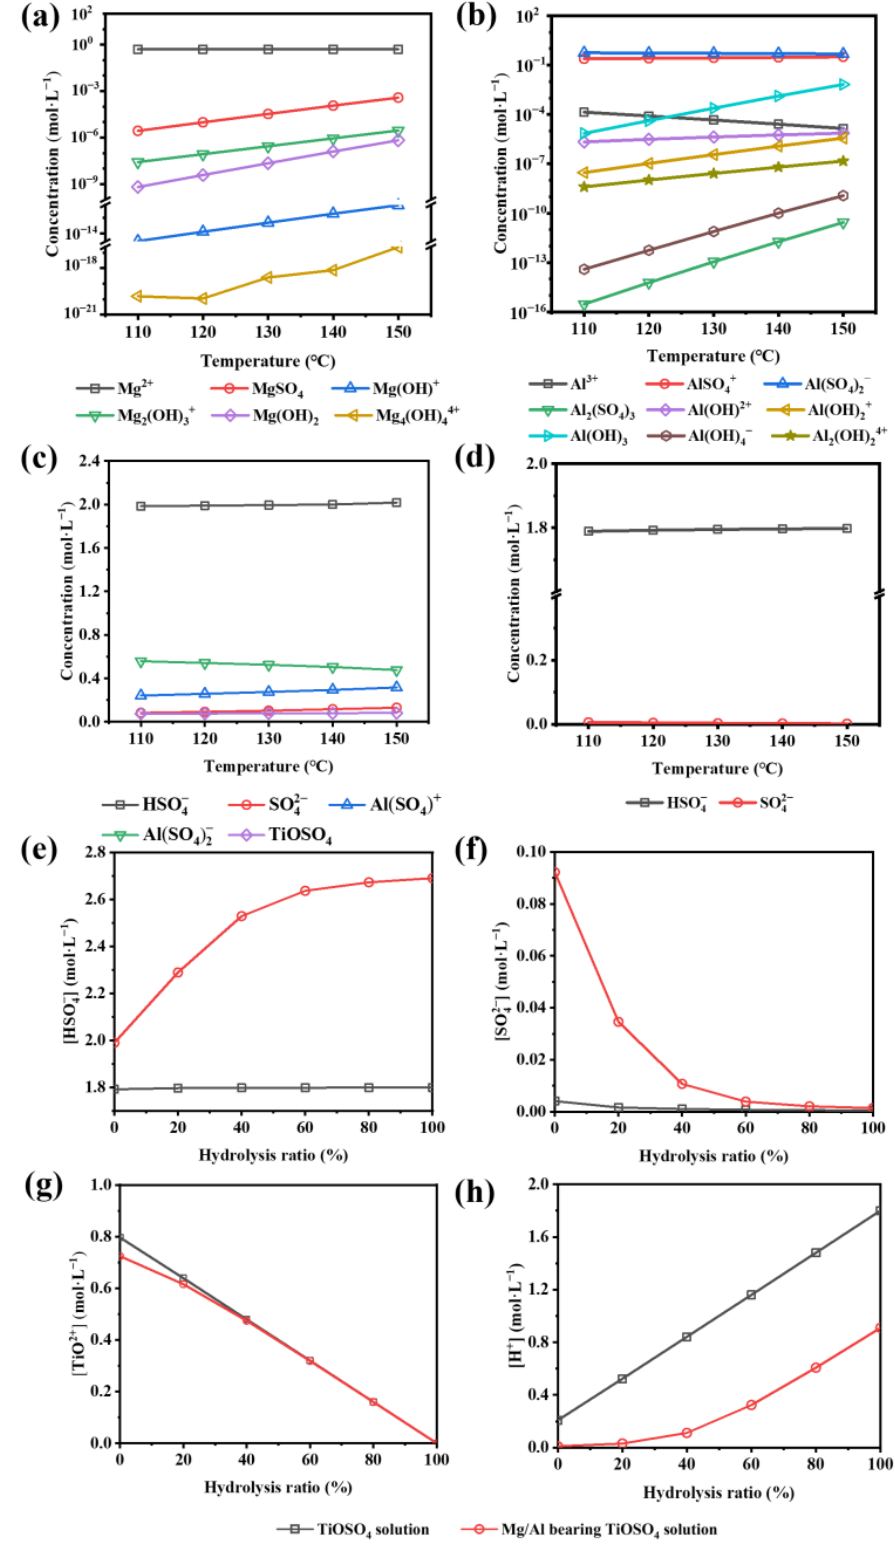
Figure 5. Initial equilibrium concentration: ( a ) Mg-containing components; ( b ) Al-containing com- ponents; ( c ) S-containing components in the Mg/Al-bearing TiOSO 4 solution; ( d ) S-containing components in the TiOSO 4 solution; the curves of the ion concentration with the hydrolysis ratio: ( e ) TiO 2+ ; ( f ) H + ; ( g ) HSO 4− ; ( h ) SO 42− . In addition to associating H + with the reduction of the acidity of the solution, the effect of SO 42− itself remains to be explored. Thermodynamic calculations show that, alt- hough most SO 42− combines with H + and converts to HSO 4− , the remaining [SO 42− ] still reaches a non-negligible order of magnitude compared with TiO 2+ . In Figure 6a, two char- acteristic peaks fitted by correlated Lorentzians at 168.91 (S 2p 1/2 ) and 169.96 eV (S 2p 3/2 ) prove the bidentate complexation between the SO 42− and titanium complexes through the oxygen bridges, which fits with the FT-IR results. Such a structure will cause an electron distribution variation and positive charge excess in the side of S [27–29]. With the